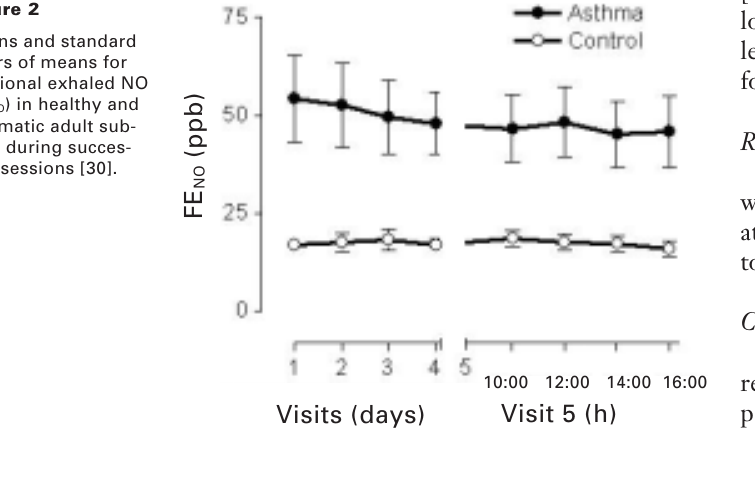
Means and standard errors of means for fractional exhaled NO (FE NO ) in healthy and asthmatic adult sub- jects during succes- sive sessions [30].